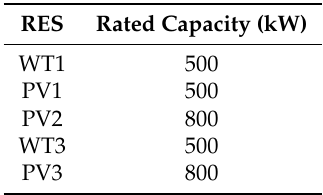
Figure 4. Structure of the MGs in coalition. PV: photovoltaic; WT: wind turbine. Table 1. Parameters of the renewable energy sources (RESs).